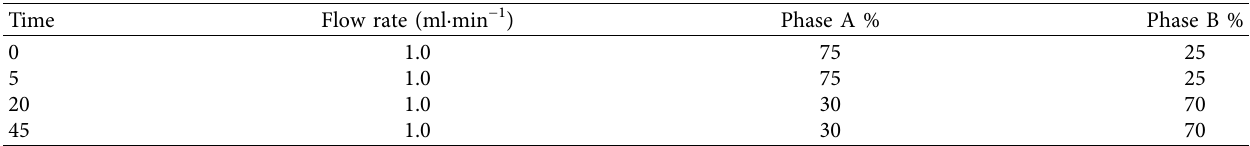
Table 2: Te proposed gradient for the elution of the HPLC analysis of the API of TFC.